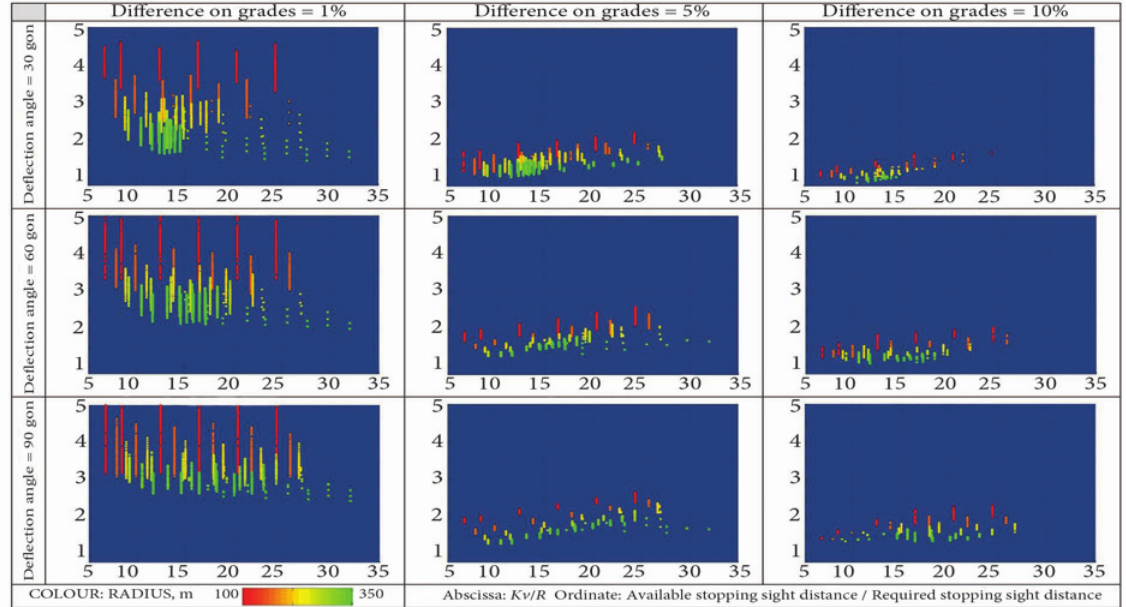
Fig. 8. Effect of on the ratio between available and required sight distance depending on radius, deflection angle and algebraic difference on